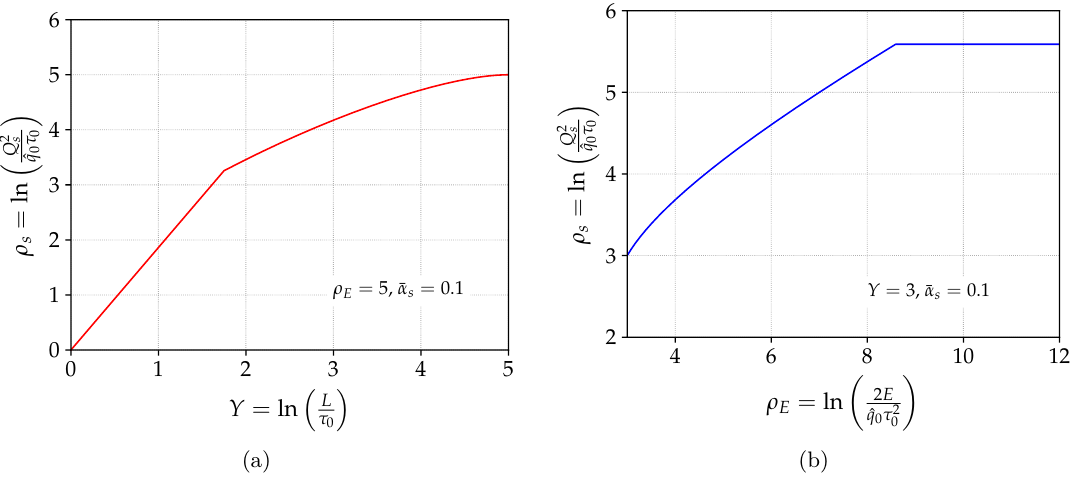
Figure 12. System size (left) and energy (right) dependence of the saturation momentum from the DLA asymptotic result